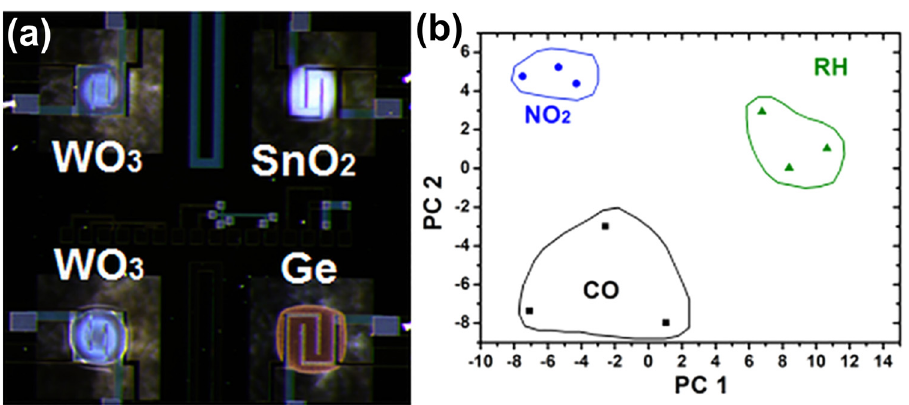
Figure 7: ( a ) Optical images of the blue tungsten oxide WO 3 − x NWs, the white SnO 2 NW deposit, and brown coating of Ge. ( b ) PCA from SnO 2 , WO 3 , and Ge NW - based gas sensors showing clustered CO, NO 2 , and RH points. Reprinted with permission from ref. [ 46 ] .